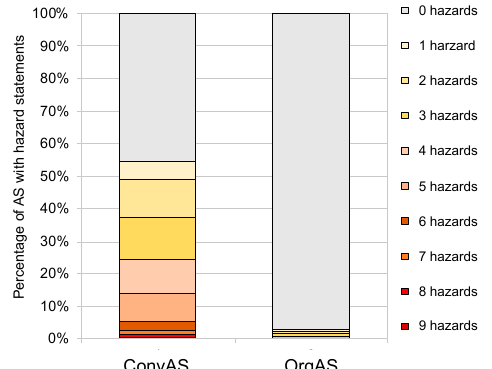
Figure 5. Comparison of the relative numbers of human toxicity hazard statements of active sub- stances (AS) approved for use in conventional (ConvAS, n = 256) and organic agriculture (OrgAS, n = 134).